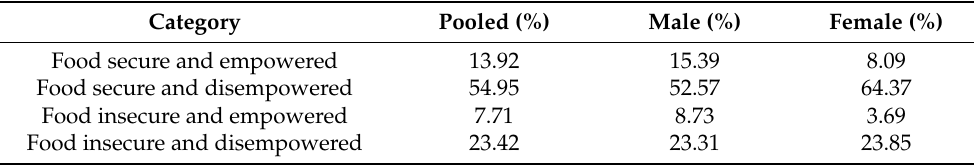
Table 9. Distribution of households based on their food security and empowerment levels.